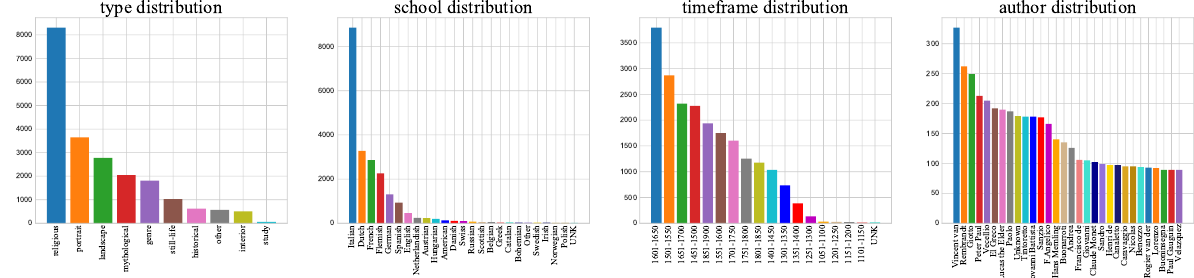
Figure 2. Class distribution of the style ( left 1 ), school ( left 2 ), timeframe ( right 2 ), author ( right 1 ). To better display the author distribution, we show only the top 30 artists; their names have been simplified to improve the figure.